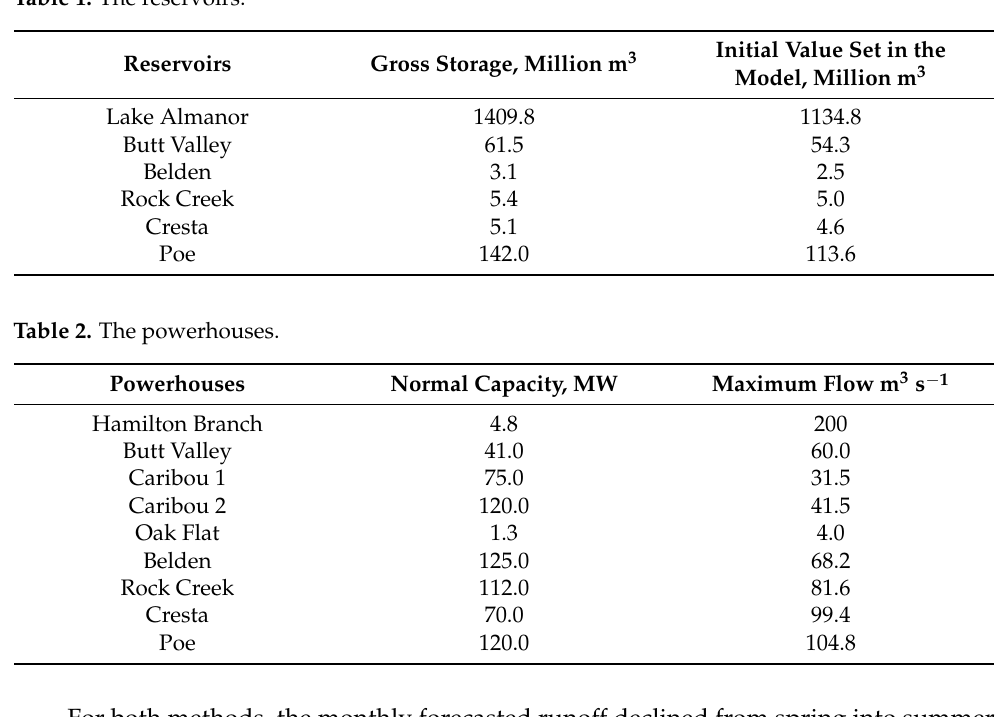
Table 1. The reservoirs.